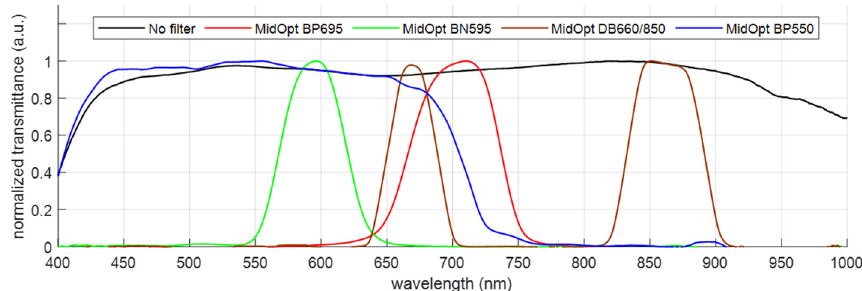
Figure 7. Transmittance spectrum for the different visible and NIR imaging channels, after the cementing of their respective optical filters.